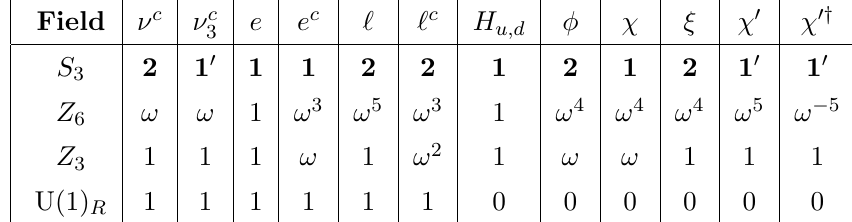
Table 4 . Transformation of the matter super(cid:12)elds under the S 3 family